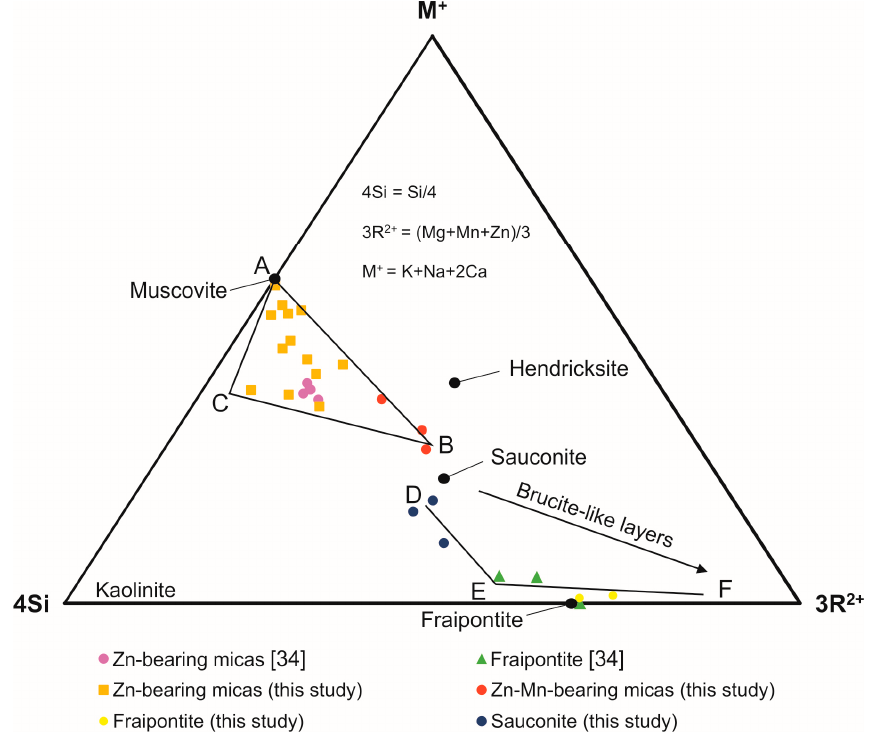
Figure 7. 4Si-M + -3R 2+ ternary diagram showing the chemical compositions of micas and clays identified in the Cristal and Mina Grande samples. Muscovite, hendricksite, sauconite, and fraipontite compositions, as reported in the IMA database. Due to the compositions of the studied minerals, for the calculation of the 3R 2+ component Mn was used instead of Fe.